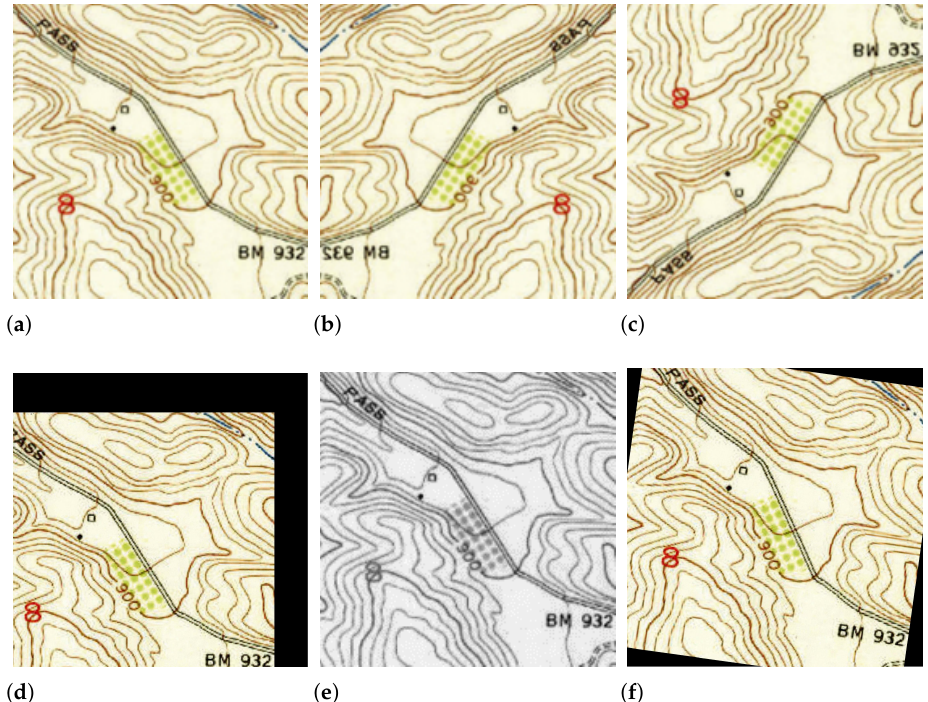
Figure 10. Images obtained by applying the data augmentation methods to the original image ( a ): ( b ) with a horizontal flip, ( c ) with vertical flipping, ( d ) with cropping, ( e ) ToGray, and ( f ) by rotating at a small angle.